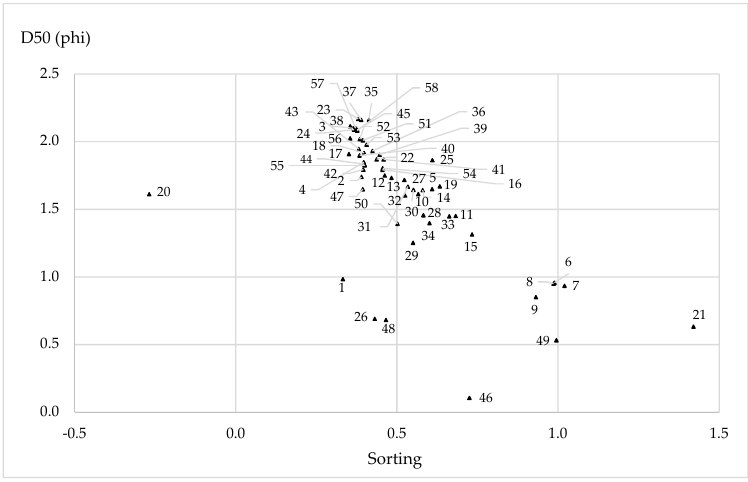
Figure 7. Sedimentological characteristics of analyzed sandy samples.